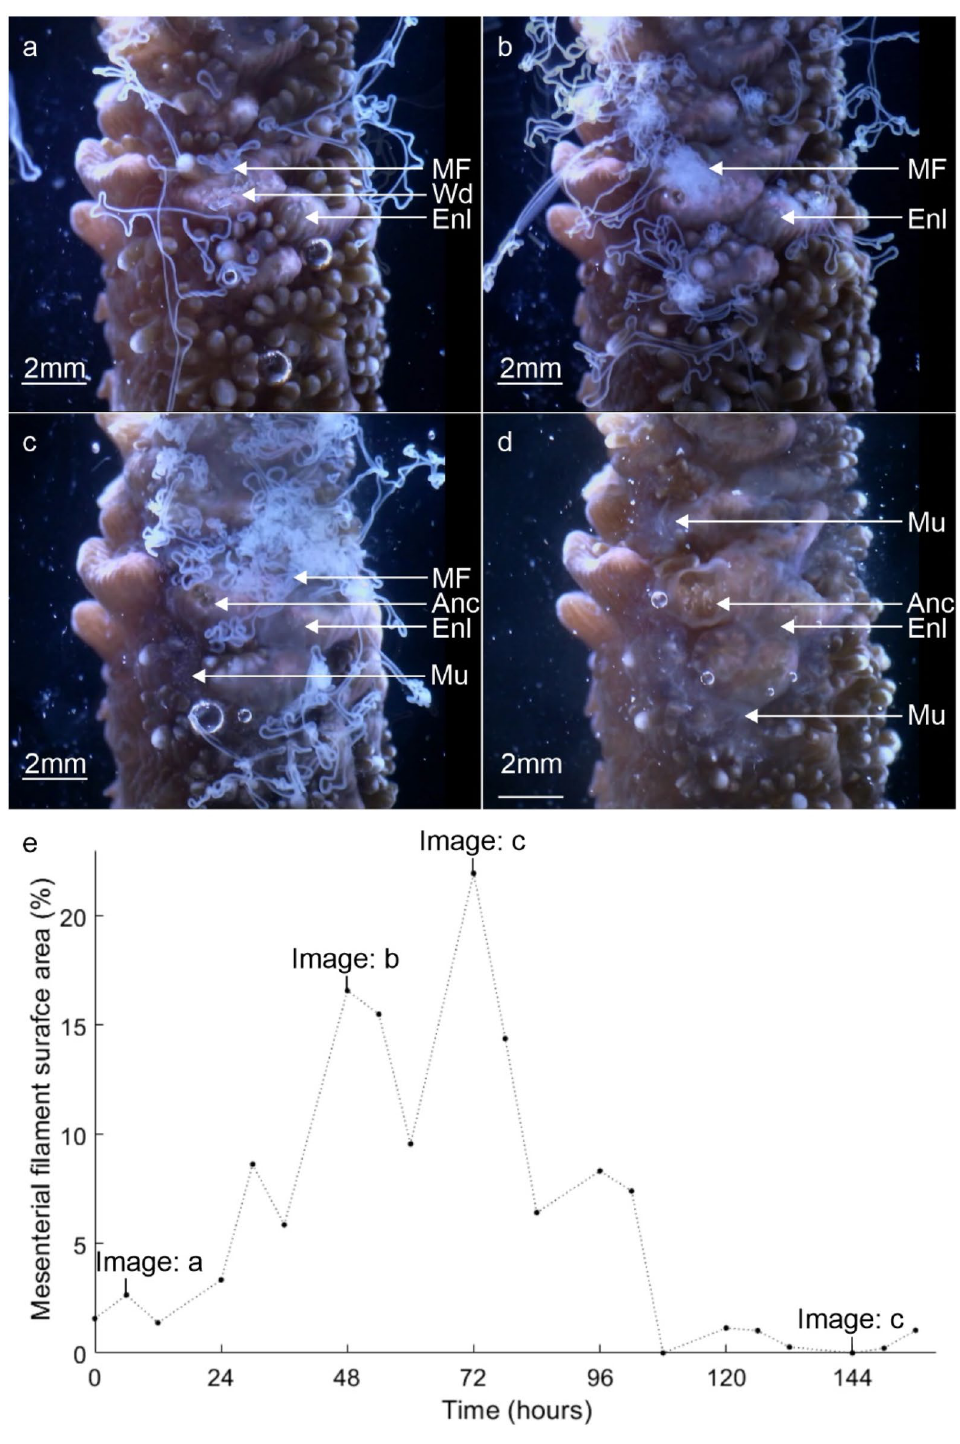
Figure 2. Stills from time-lapse light microscope movies displaying the representative processes that characterise the contact response phase, i.e., tissue enlargement, mucus release, wound cleaning (0–5 days). ( a ) Wounds (Wd) formed by abrasion are cleaned by mesenterial filaments (MF) as the surrounding immunocompromised tissues become enlarged (Enl). ( b , c ) Mesenterial filament deployment is increased external to the body cavity as the compromised tissues become further enlarged (2–3 days). ( d ) Mucus (Mu) secretions that have formed on the substrate surface surrounding the compromised tissues change colour over time—from transparent to white or brown. ( e ) A plot showing the relative density of the mesenterial filaments activity inside and outside the body cavity on each day the still (a,b,c,d) was captured. Wound; Wd, Enlarged tissues; Enl, mesenterial filaments; MF, mucus layer;